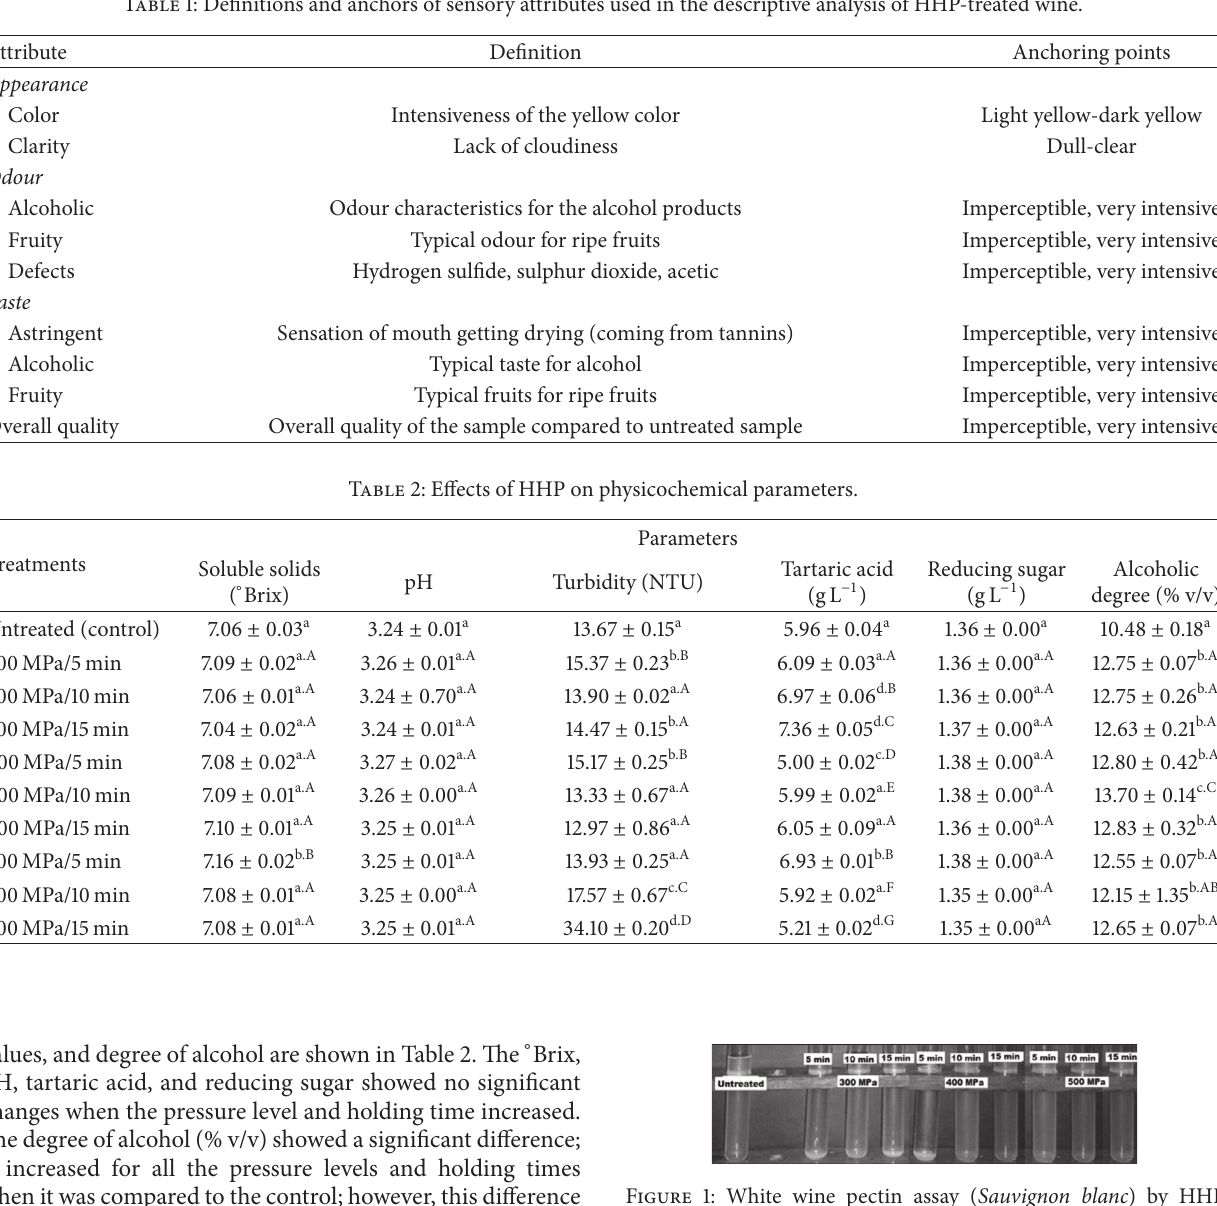
Figure 1: White wine pectin assay ( Sauvignon blanc ) by HHP